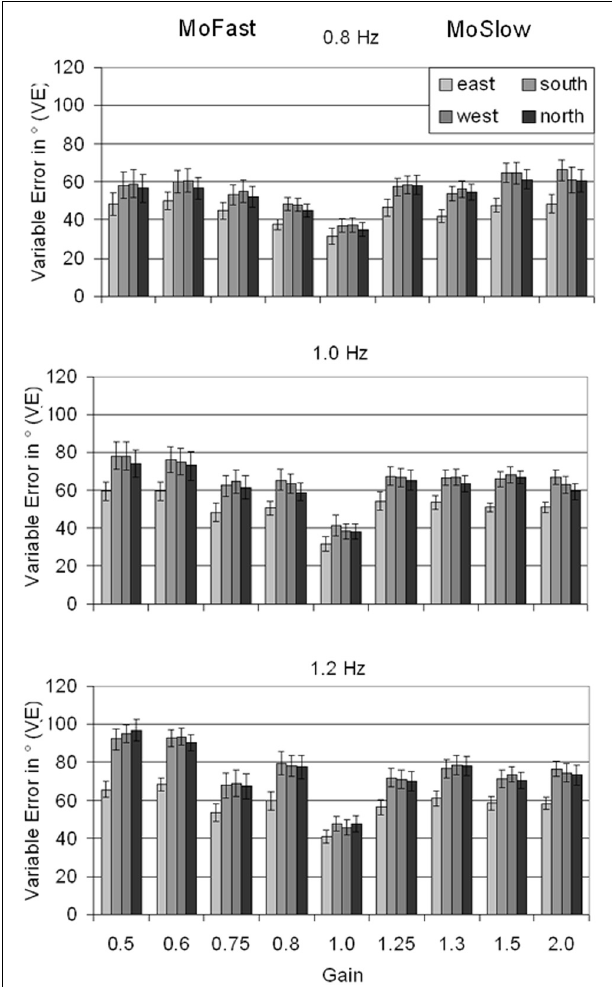
FIGURE 3 | Means and standard errors forVariable Error depending on location, gain, and visual speed. MoFast = gains smaller than 1, movement speed is faster than visual speed. MoSlow = gains higher than 1, movement speed is slower than visual speed.